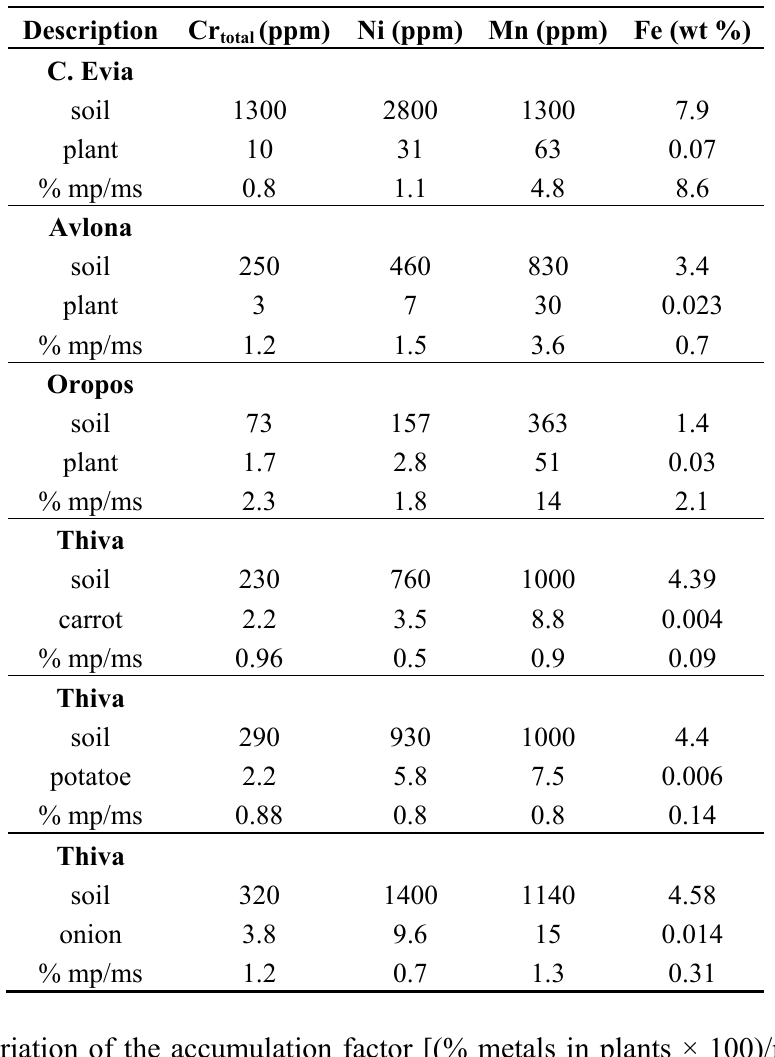
Table 4. Percentage of soil metal in plants. Data from present study and [18–22].